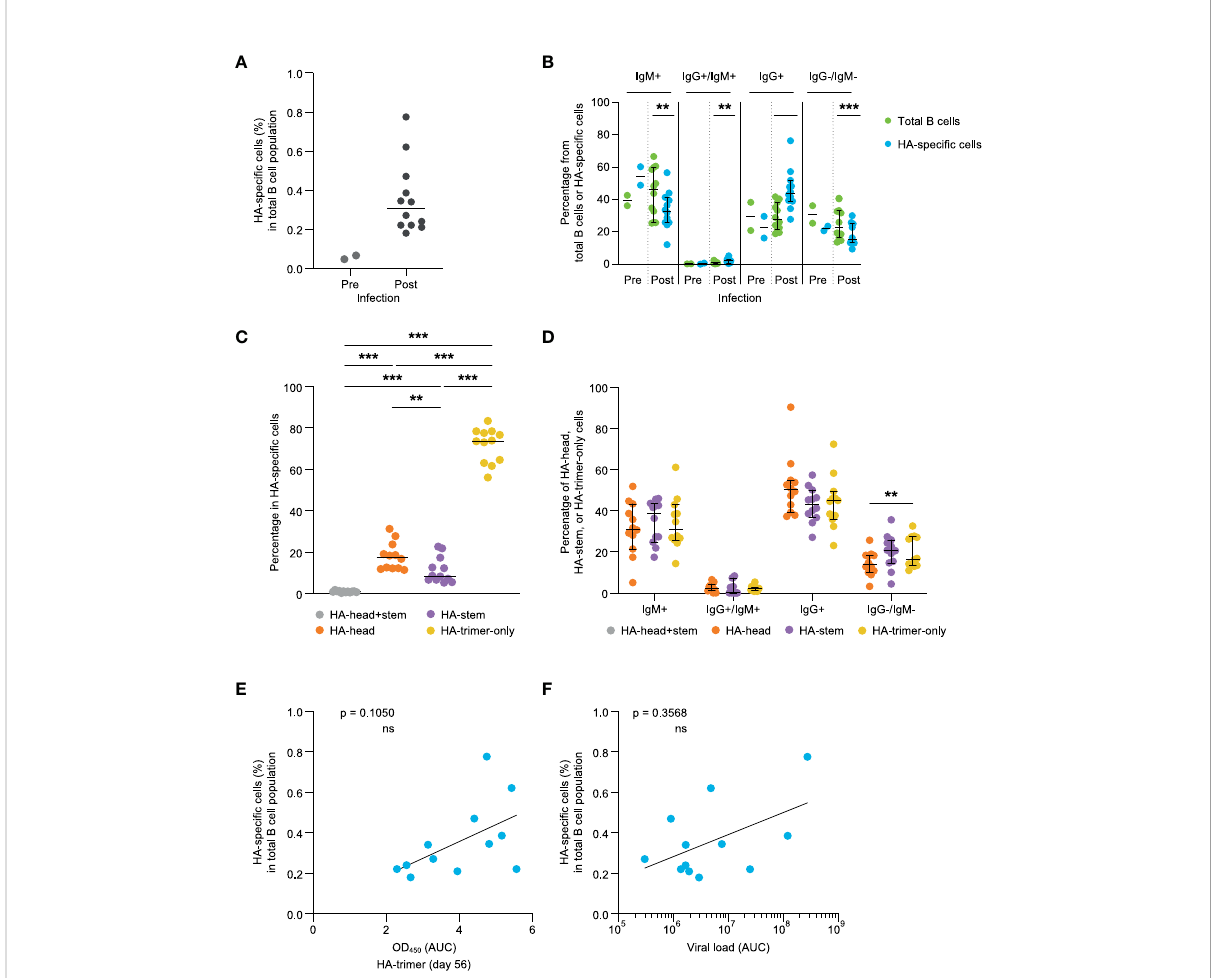
FIGURE 2 Evaluation of HA-speci fi c B cell responses at day 56 post-infection (A) Percentage of the HA-speci fi c B cells of pre- (green) and post-infection (blue) samples. (B) Comparison of the percentage of IgM+, IgG+/IgM+, IgG+, and IgG-/IgM- B cells detected in the total B cell pool (green) and HA-speci fi c B cells (blue). (C) Frequency of HA-head+stem (grey), HA-head (orange), HA-stem (purple), and HA-trimer-only (yellow) binding B cells within the total HA-speci fi c binding B cells. (D) Percentage of IgM+, IgG+/IgM+, IgG+, and IgG-/IgM- B cells observed within the HA-head +stem (grey), HA-head (orange), HA-stem (purple), and HA-trimer-only (yellow) populations of HA-speci fi c cells. (E) Correlation between HA- speci fi c antibody response (AUC) and frequency of HA-speci fi c B cells measured at day 56. (F) Correlation between cumulative viral load in tracheal swabs (AUC) and frequency of HA-speci fi c B cells at day 56. Statistical differences between two groups were determined using the Wilcoxon test (p values: **p < 0.01; ***p < 0.001), bars represent medians with 95% CI, and correlations were determined using a Spearman correlation test (ns, not signi fi